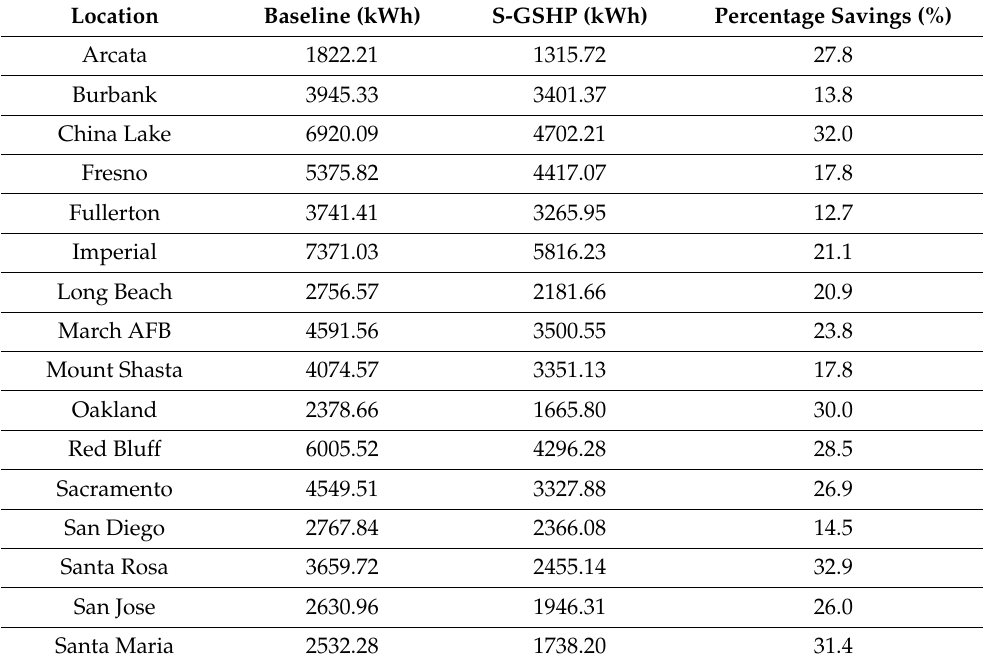
Table 4. Annual combined heating and cooling energy consumption for both baseline and shallow GSHP systems for all California